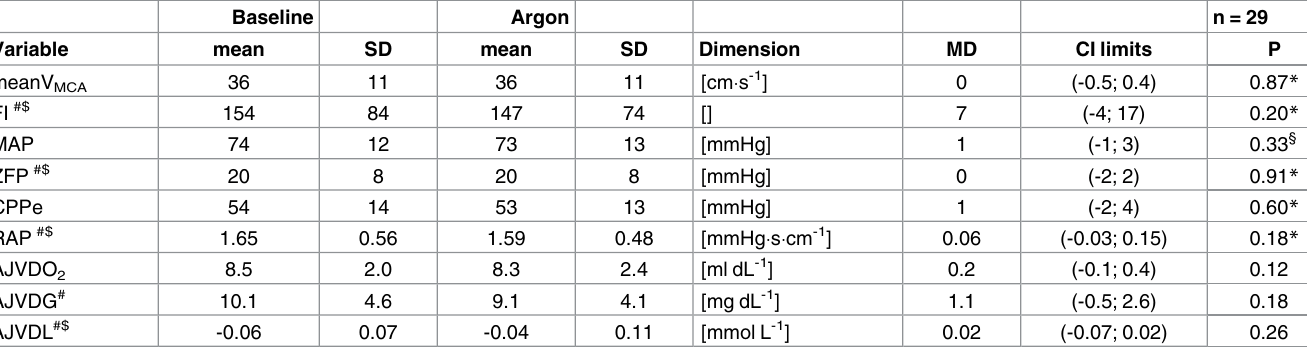
Table 1. Haemodynamic and metabolic